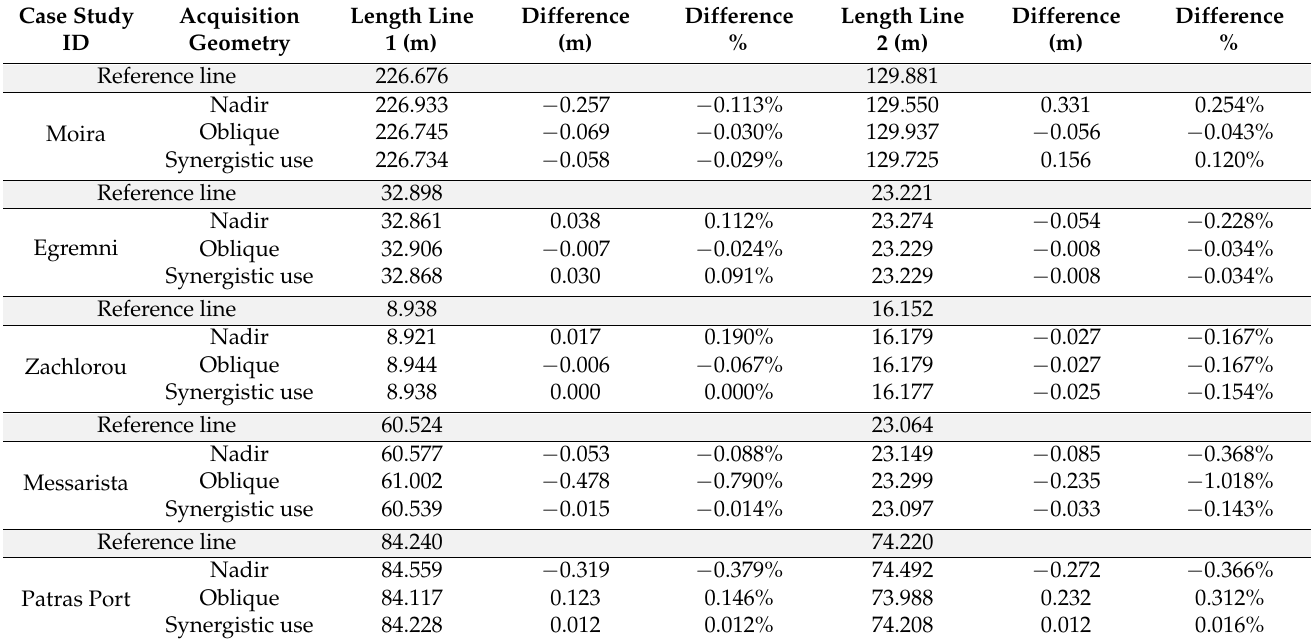
Table 3. Comparison of the length of the geodetic lines of each case study in accordance with the respective reference